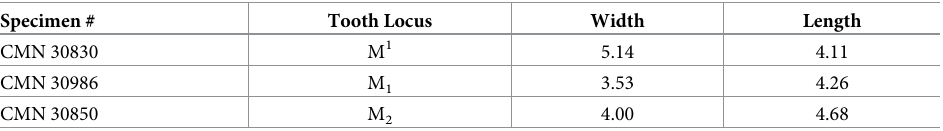
Table 1. Summary of dental measurements (in mm) for Ignacius mckennai from Ellesmere Island, Nunavut,